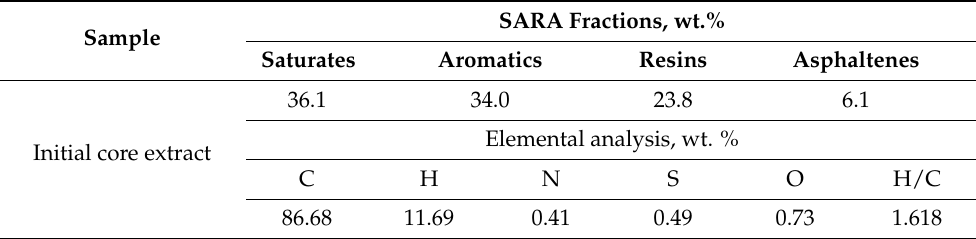
Table 1. Group composition (SARA) and elemental analysis of oil extract from the initial crushed